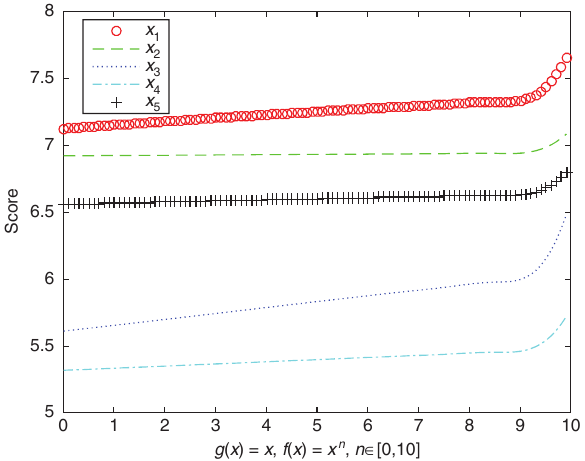
Figure 4: Scores with g ( x ) = x , f ( x ) = x n